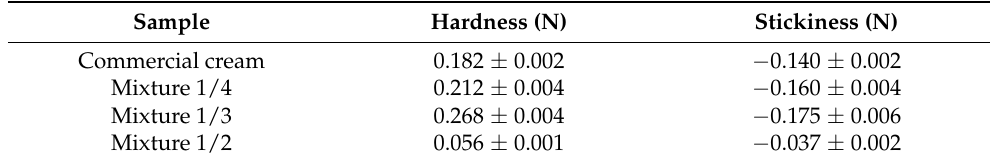
Table 2. Results of the texturometry tests for the commercial cream and mixtures of the commercial cream with the double emulsion W 1 /O/W 2 of concentration 80/20 with an internal phase ratio W 1 /O of 30/70.